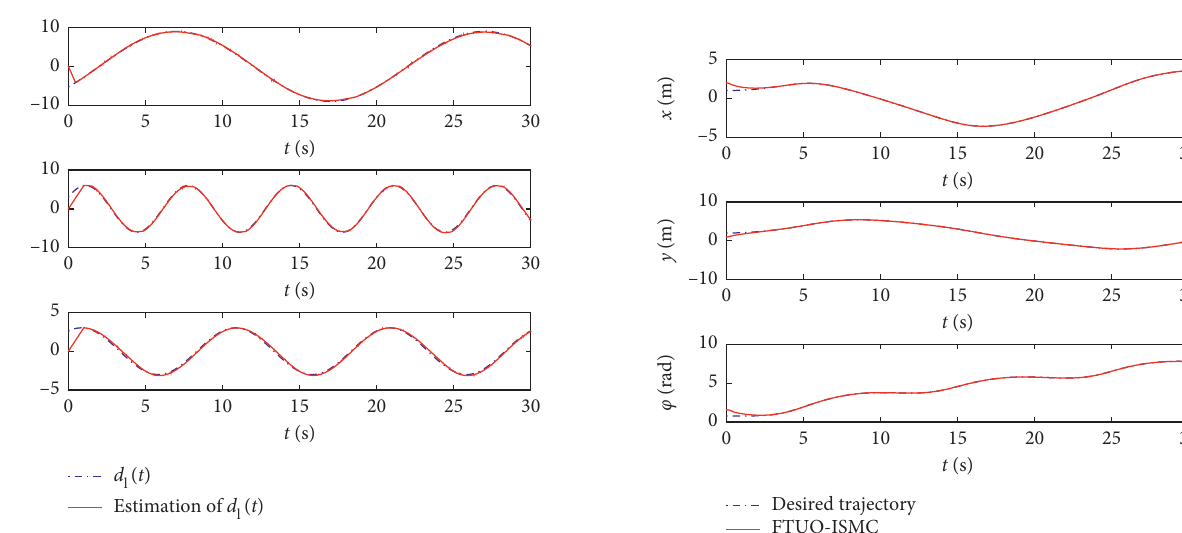
Figure 11: Velocity tracking errors on ISMC and FTDO-ISMC.